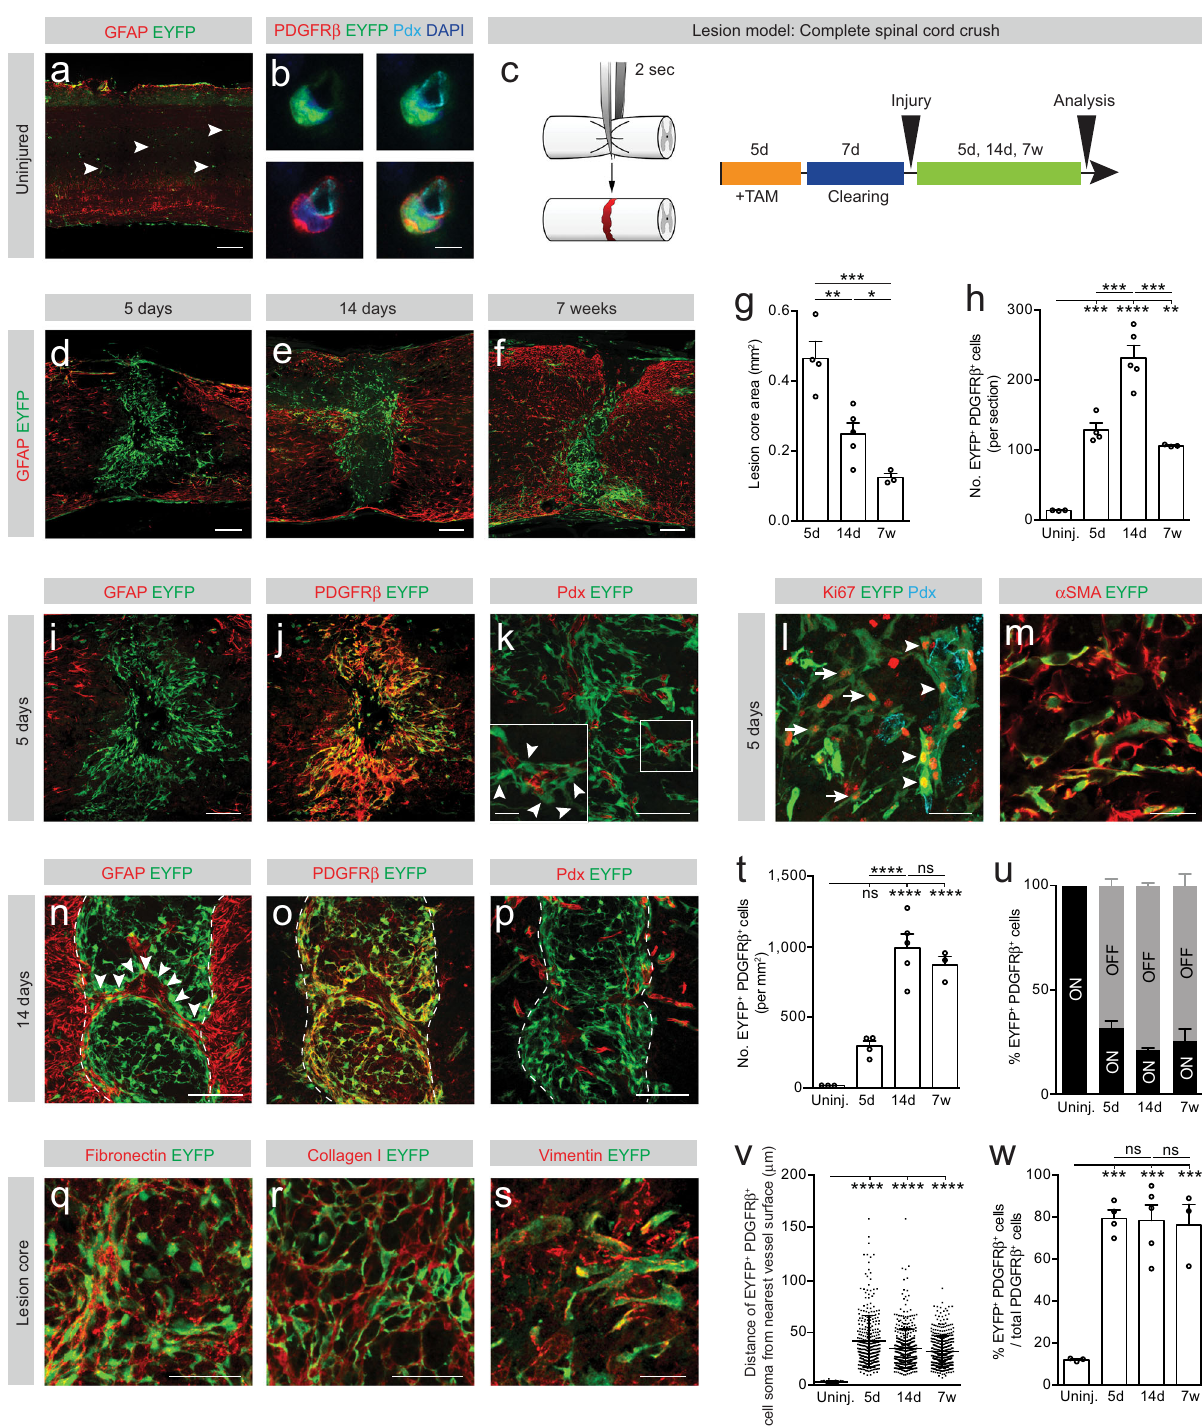
At 14 dpi the fi brotic lesion core was fl anked by glial fi brillary acidic protein (GFAP) + astrocytes, establishing a sharp border between the glial and fi brotic scar compartments (Figs. 1n, o and Supplementary Fig. 7a – c). As a result of lesion border formation, type A pericyte-derived cells apposed to reactive glia at the glial- fi brotic interface exhibited a distinct morphology and arranged differently compared to EYFP + cells in the inner core of the fi brotic scar (Supplementary Fig. 7b, c). In regions of the scar devoid of type A pericyte-derived cells, we could observe GFAP + astrocyte processes crossing the lesion site, forming glial